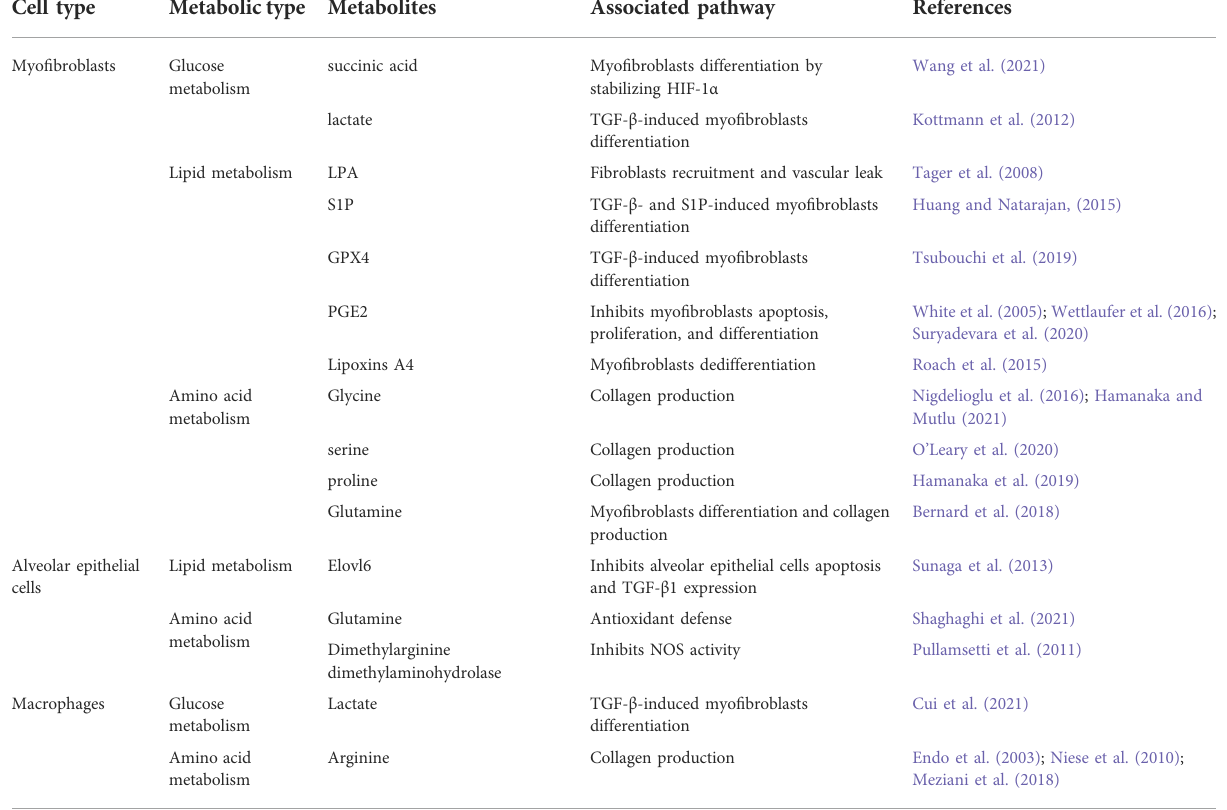
TABLE 1 Overview of the connection of metabolites with pro-in fl ammatory and pro- fi brotic pathways in Pulmonary fi